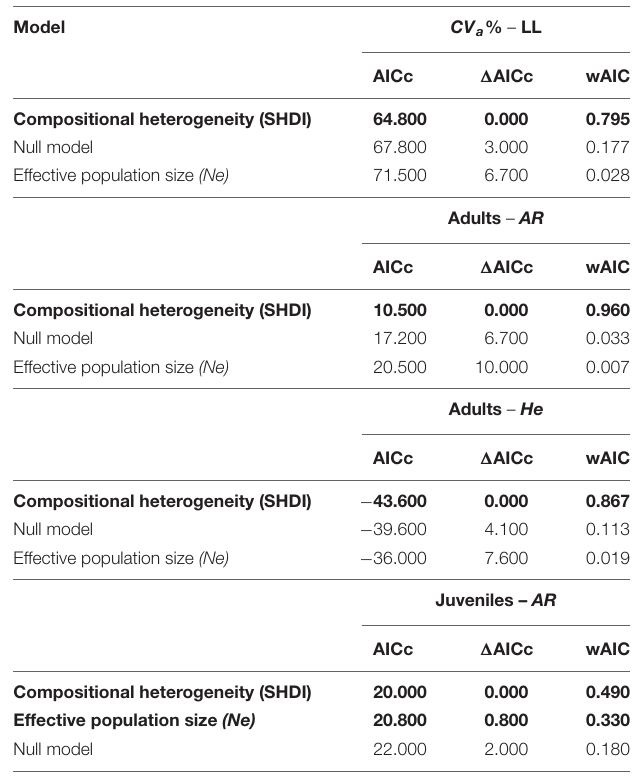
TABLE 2 | Model selection to explain variation in neutral genetic diversity and adaptive quantitative traits variation in populations of Caryocar brasiliense in landscapes of the Brazilian